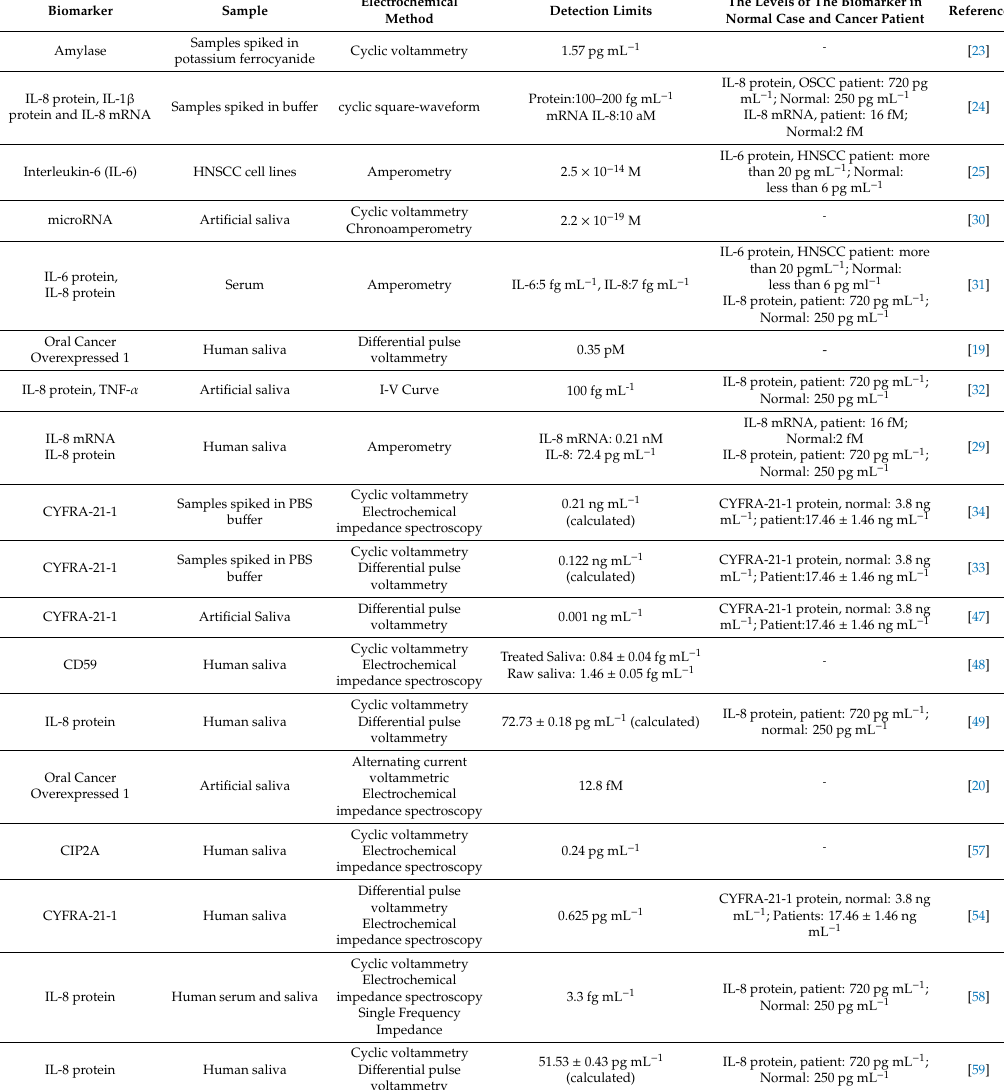
Table 1. Biomarkers that have been used for oral cancer electrochemical biosensors and the experimental conditions. Biomarker Sample Electrochemical Method DetectionLimits TheLevelsofTheBiomarkerin NormalCaseandCancerPatient References